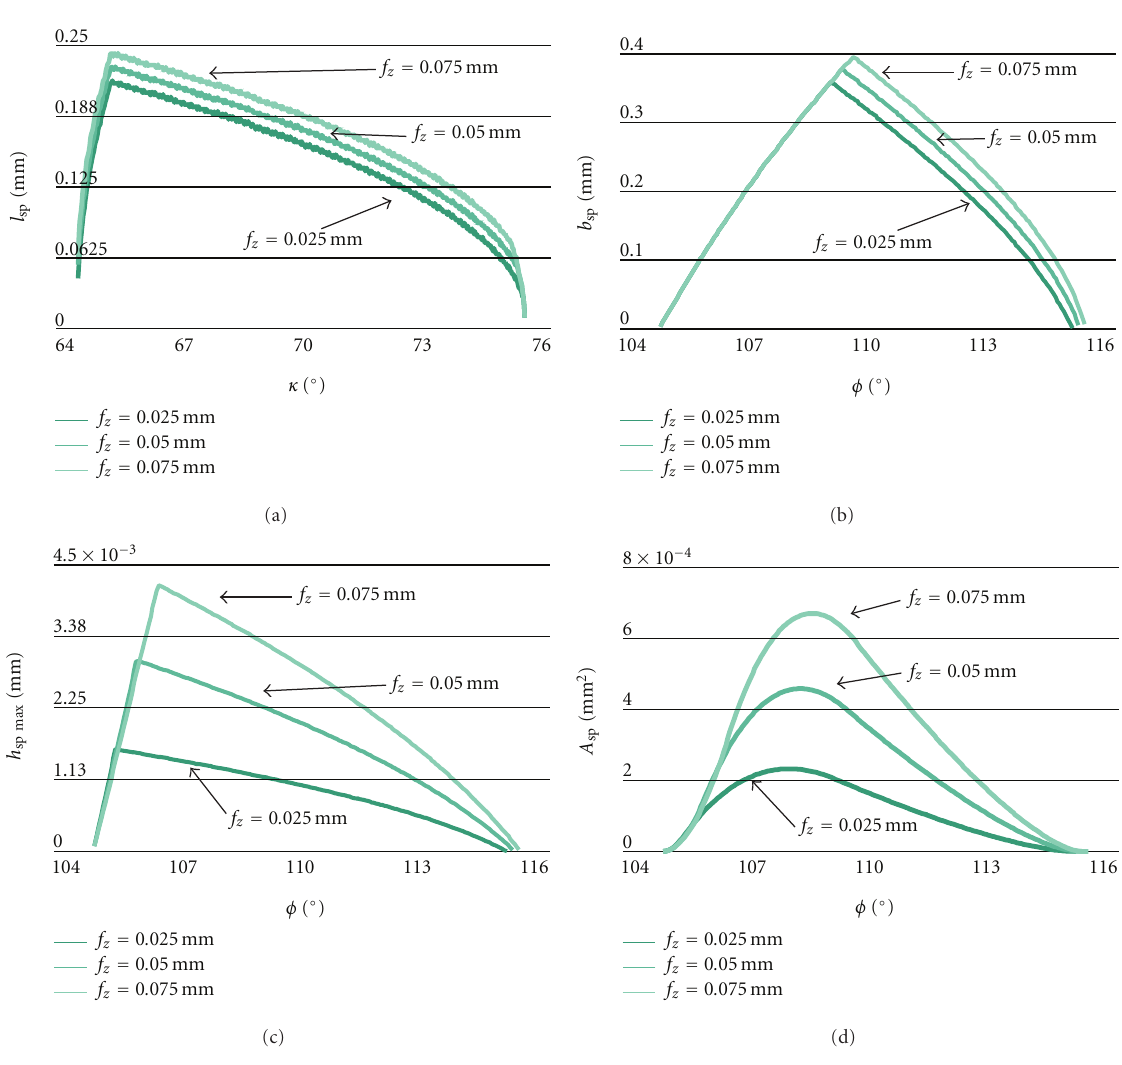
Figure 11: Influence of the feed-rate on the chip